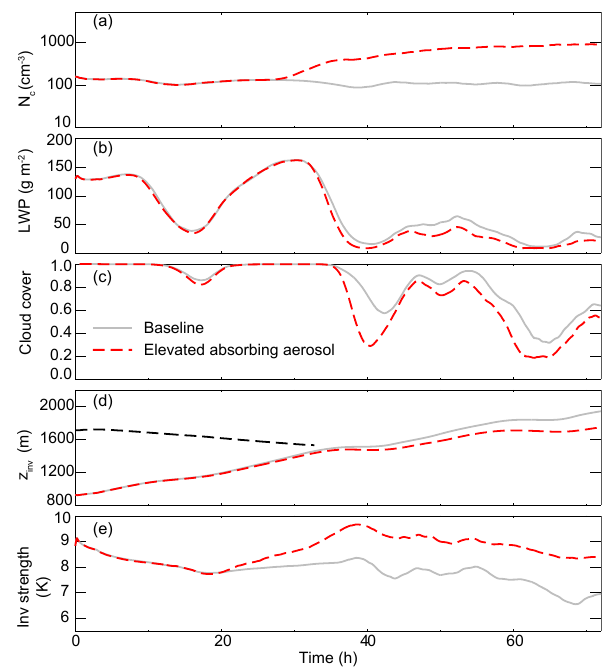
Figure 7. As in Fig. 2. The baseline with a 3.5km deep grid ( N a , sulfate = 150mg − 1 ) shown as gray solid line. Results with the aerosol layer initially 400m higher shown as red dashed line, with the corresponding aerosol layer base shown as black dashed line in (d)